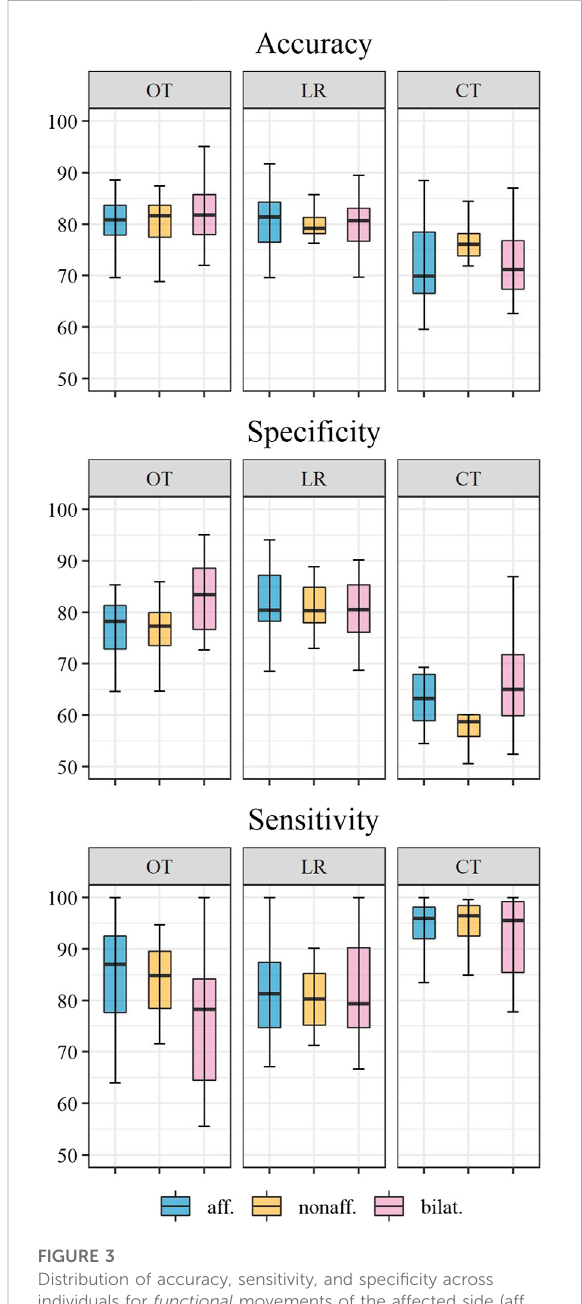
FIGURE 3 Distribution of accuracy, sensitivity, and speci fi city across individuals for functional movements of the affected side (aff., blue), non-affected side (nonaff., orange), and bilateral activity (bilat., blue). Classi fi cation methods displayed by panels: OT; optimal thresholds; LR, logistic regression; CT, conventional thresholds.